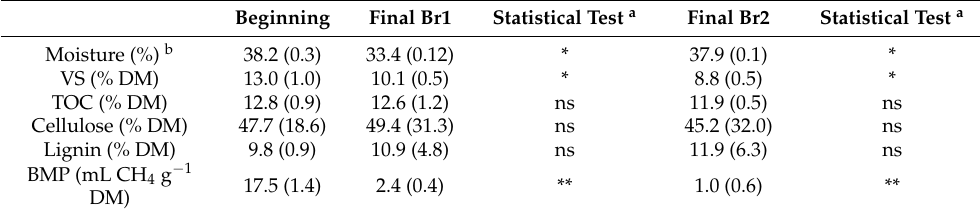
Table 4. Initial and final characterisation of EW moisture and stability